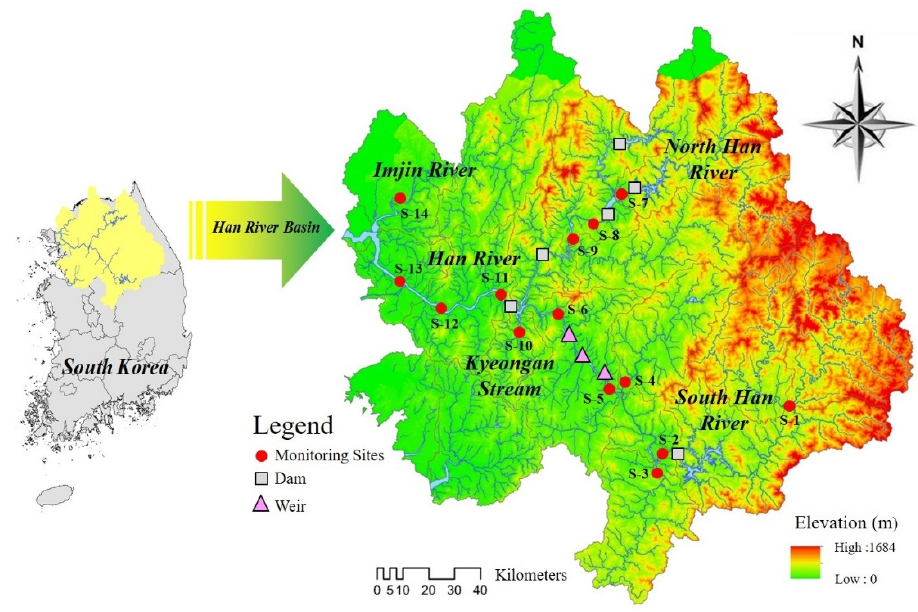
Figure 1. Map showing the water quality monitoring sites in the Han River Basin, South Korea.